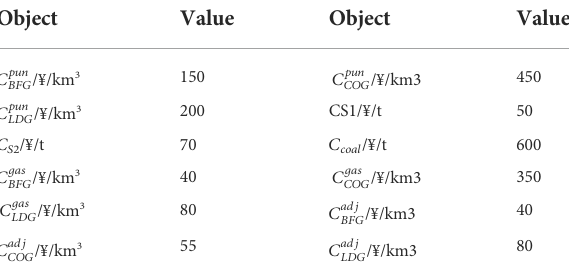
TABLE 5 Cost per unit of